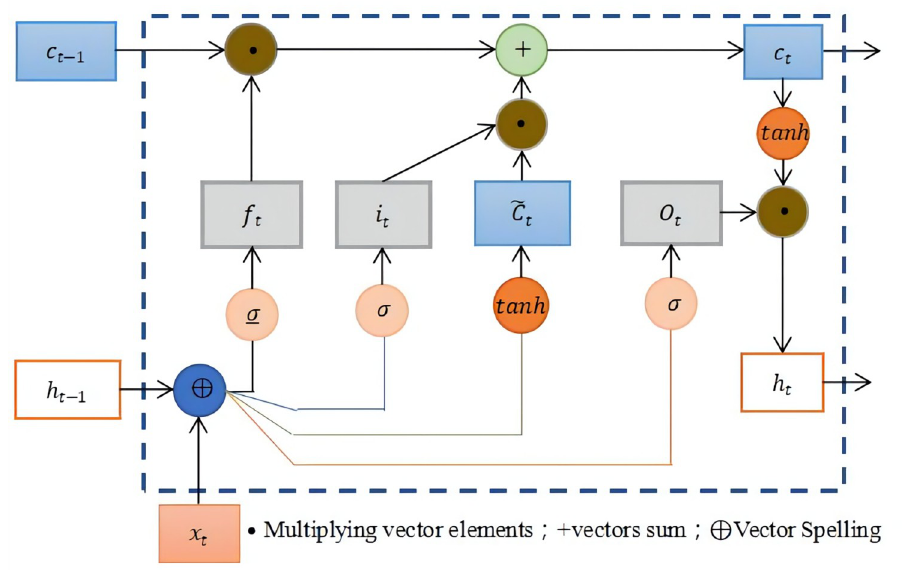
Fig 2. Structure of the long short-term memory neural network